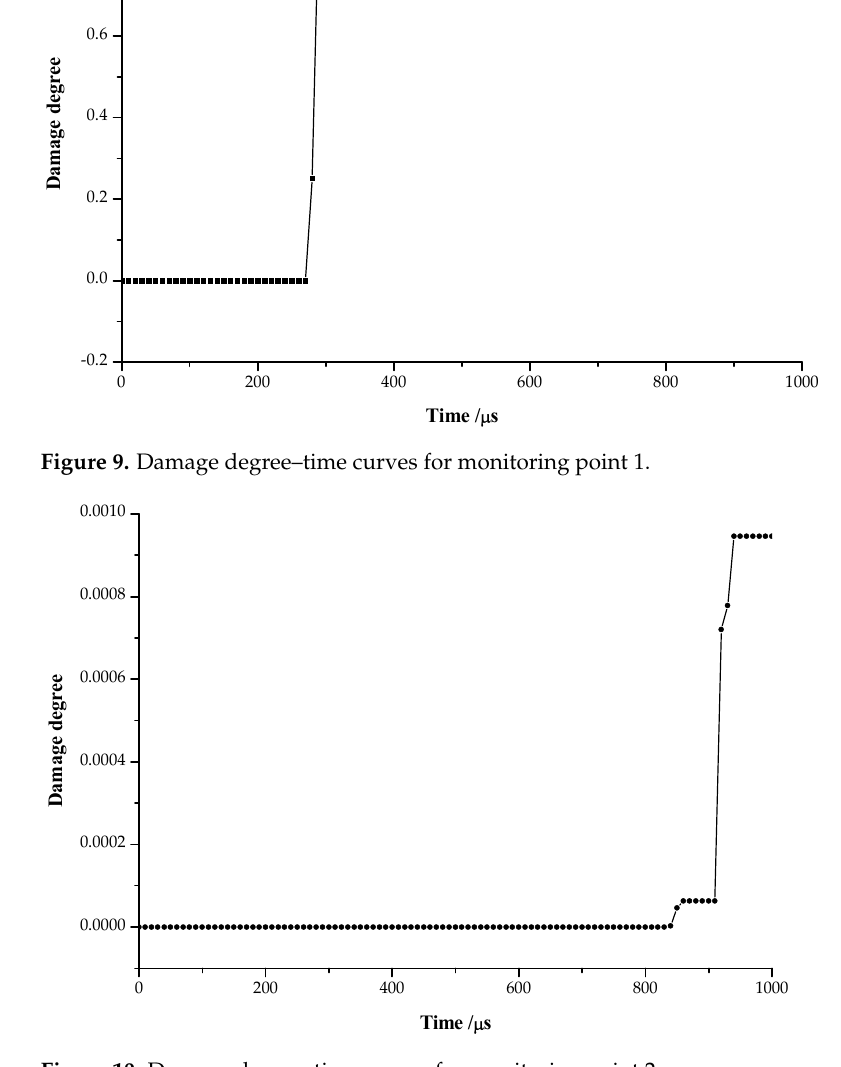
( e ) Figure 11. Blasting damage evolution law of groove-cavity in plane y = 0. ( a ) t =0 µs. ( b ) t = 200 µs. ( c ) t = 400 µs. ( d ) t = 600 µs. ( e ) t = 800 µs.